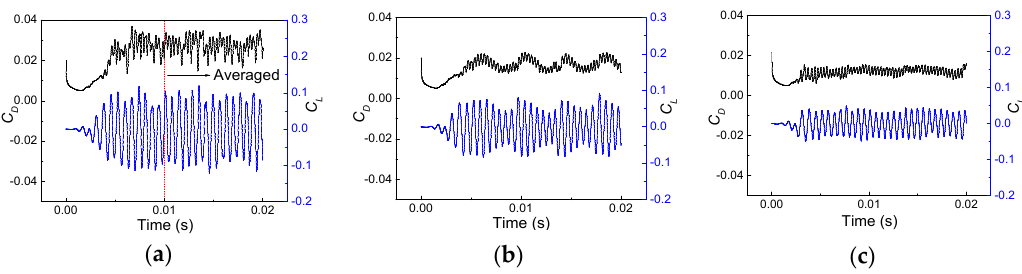
Figure 4. Time history of the lift and drag coefficients, C L and C D , at: ( a ) free cavitation conditions ( σ / σ i = 1.3); ( b ) cavitation conditions ( σ / σ i = 0.6); and ( c ) cavitation conditions ( σ / σ i = 0.4).